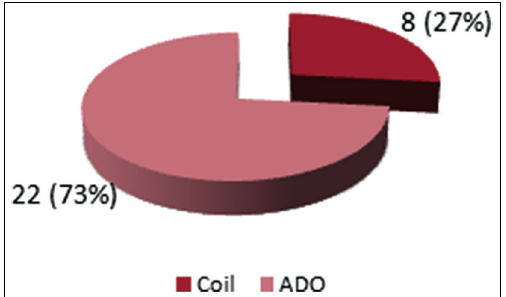
FIGURE 4. The type of occlude